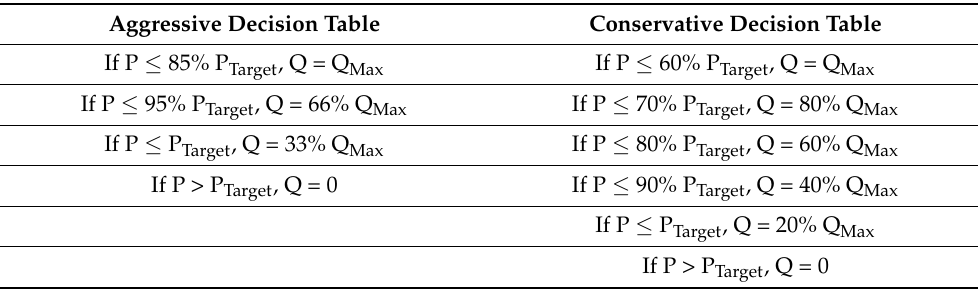
Table 1. Overview of decision table controller logic for aggressive and conservative tuning. P Target is the target pressure, which was set at 65 mmHg throughout, while P is the current pressure. Q Max is the maximum possible infusion rate of the test platform which was set at 500 mL/min throughout. Aggressive Decision Table Conservative Decision Table